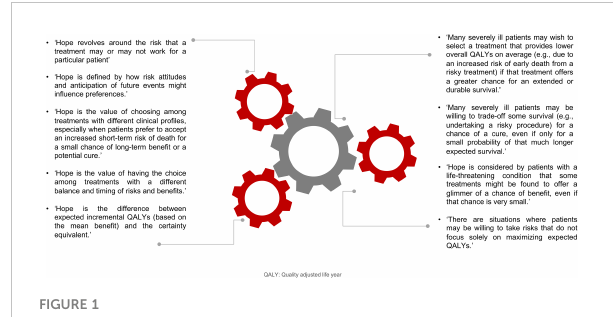
FIGURE 1 De fi nitions of ‘ hope ’ for risk-seeking patients. QALY, Quality adjusted life